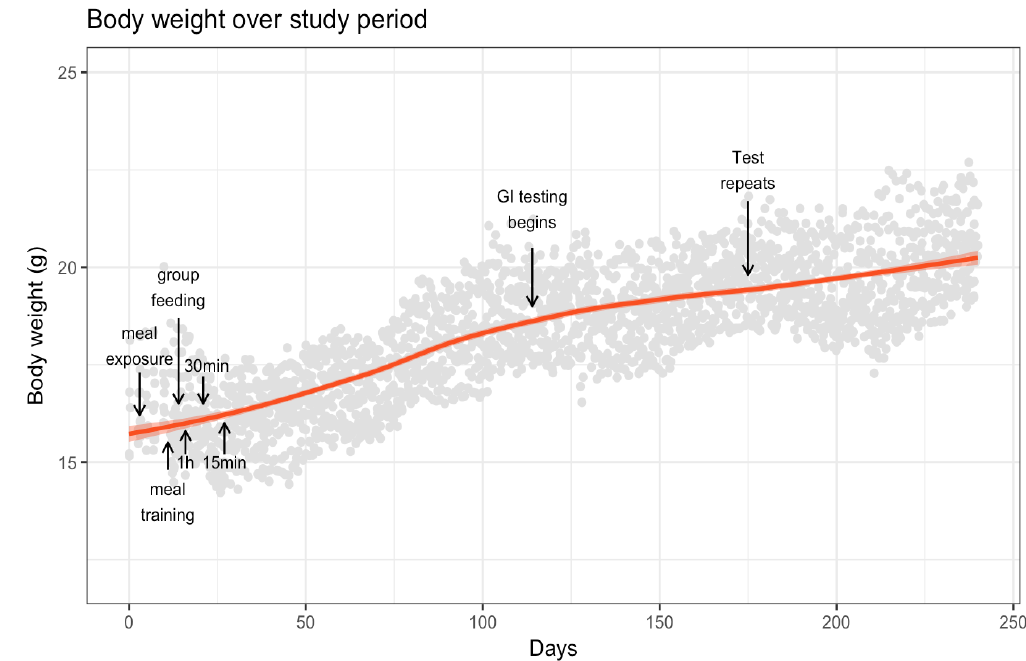
Figure 1. Smoothed mean mouse body weight across the study. Arrows and annotations in panel